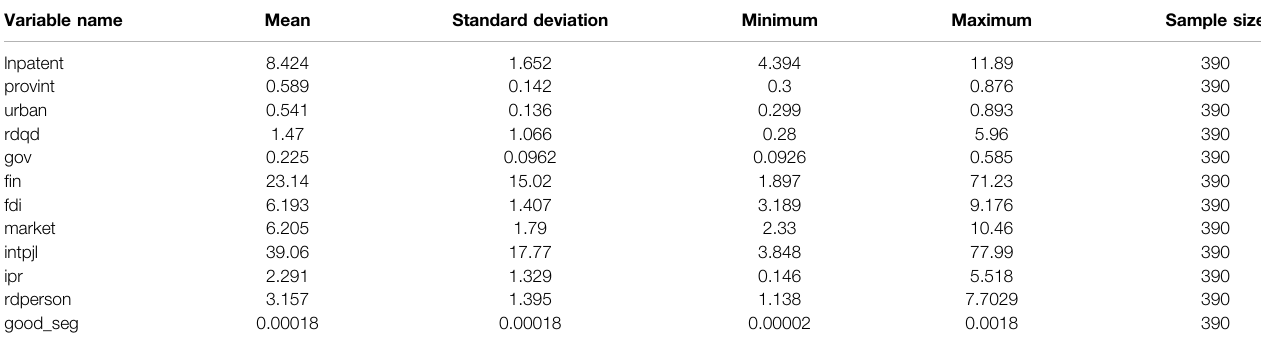
TABLE 4 | Descriptive statistics of main